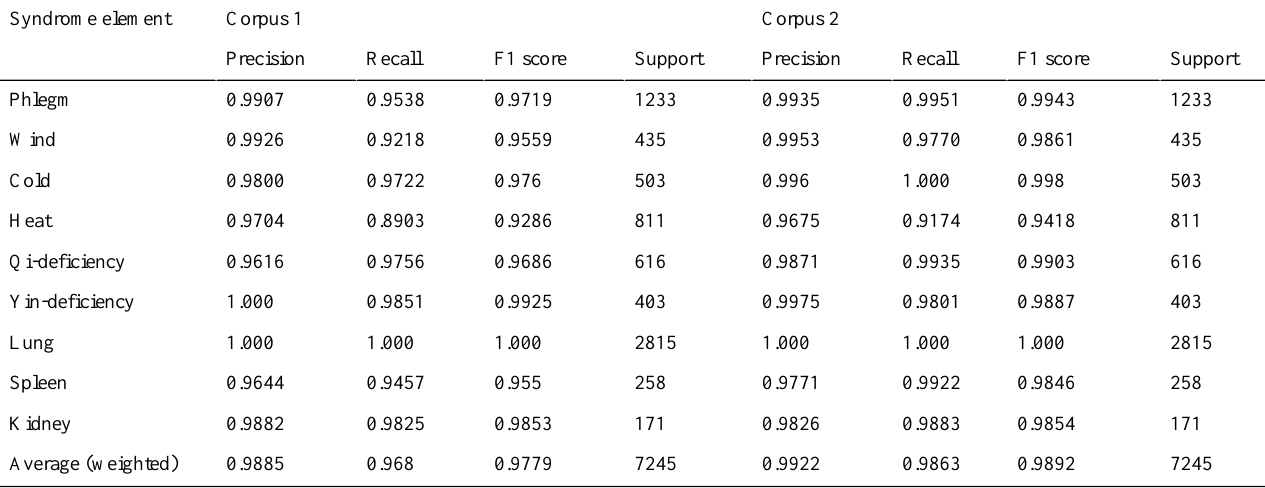
Table 6. Performance analysis of model-based reasoning methods in combination with rule-based reasoning methods for each syndrome element in the test data set with corpus 1 and corpus 2. a